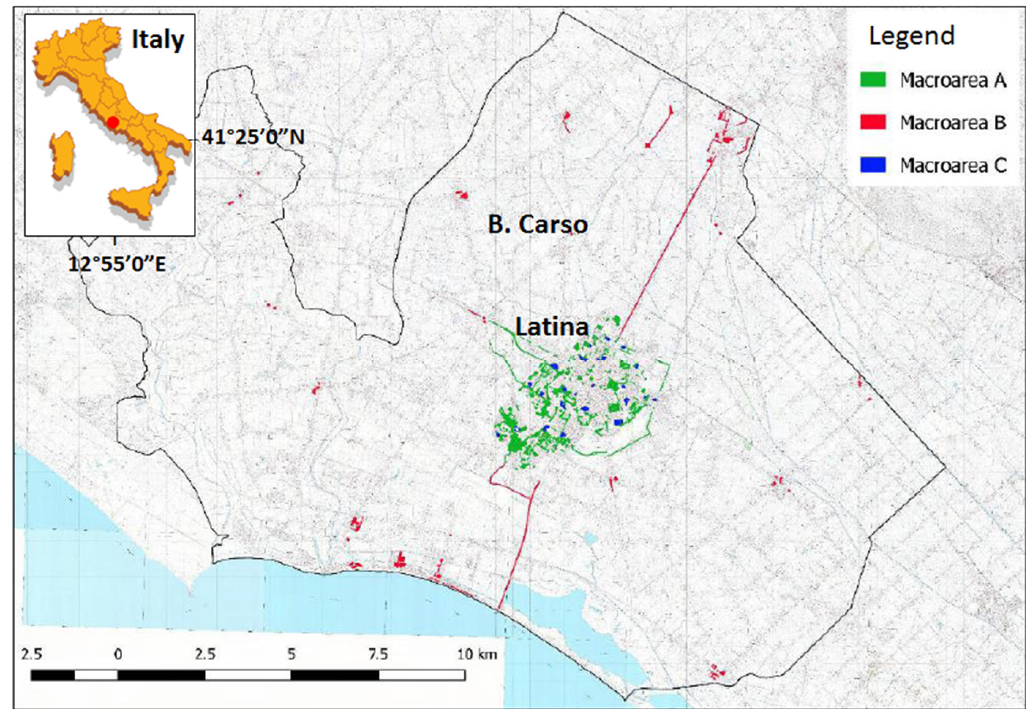
Figure 1. Study area and Green Macroareas in the Municipality of Latina.